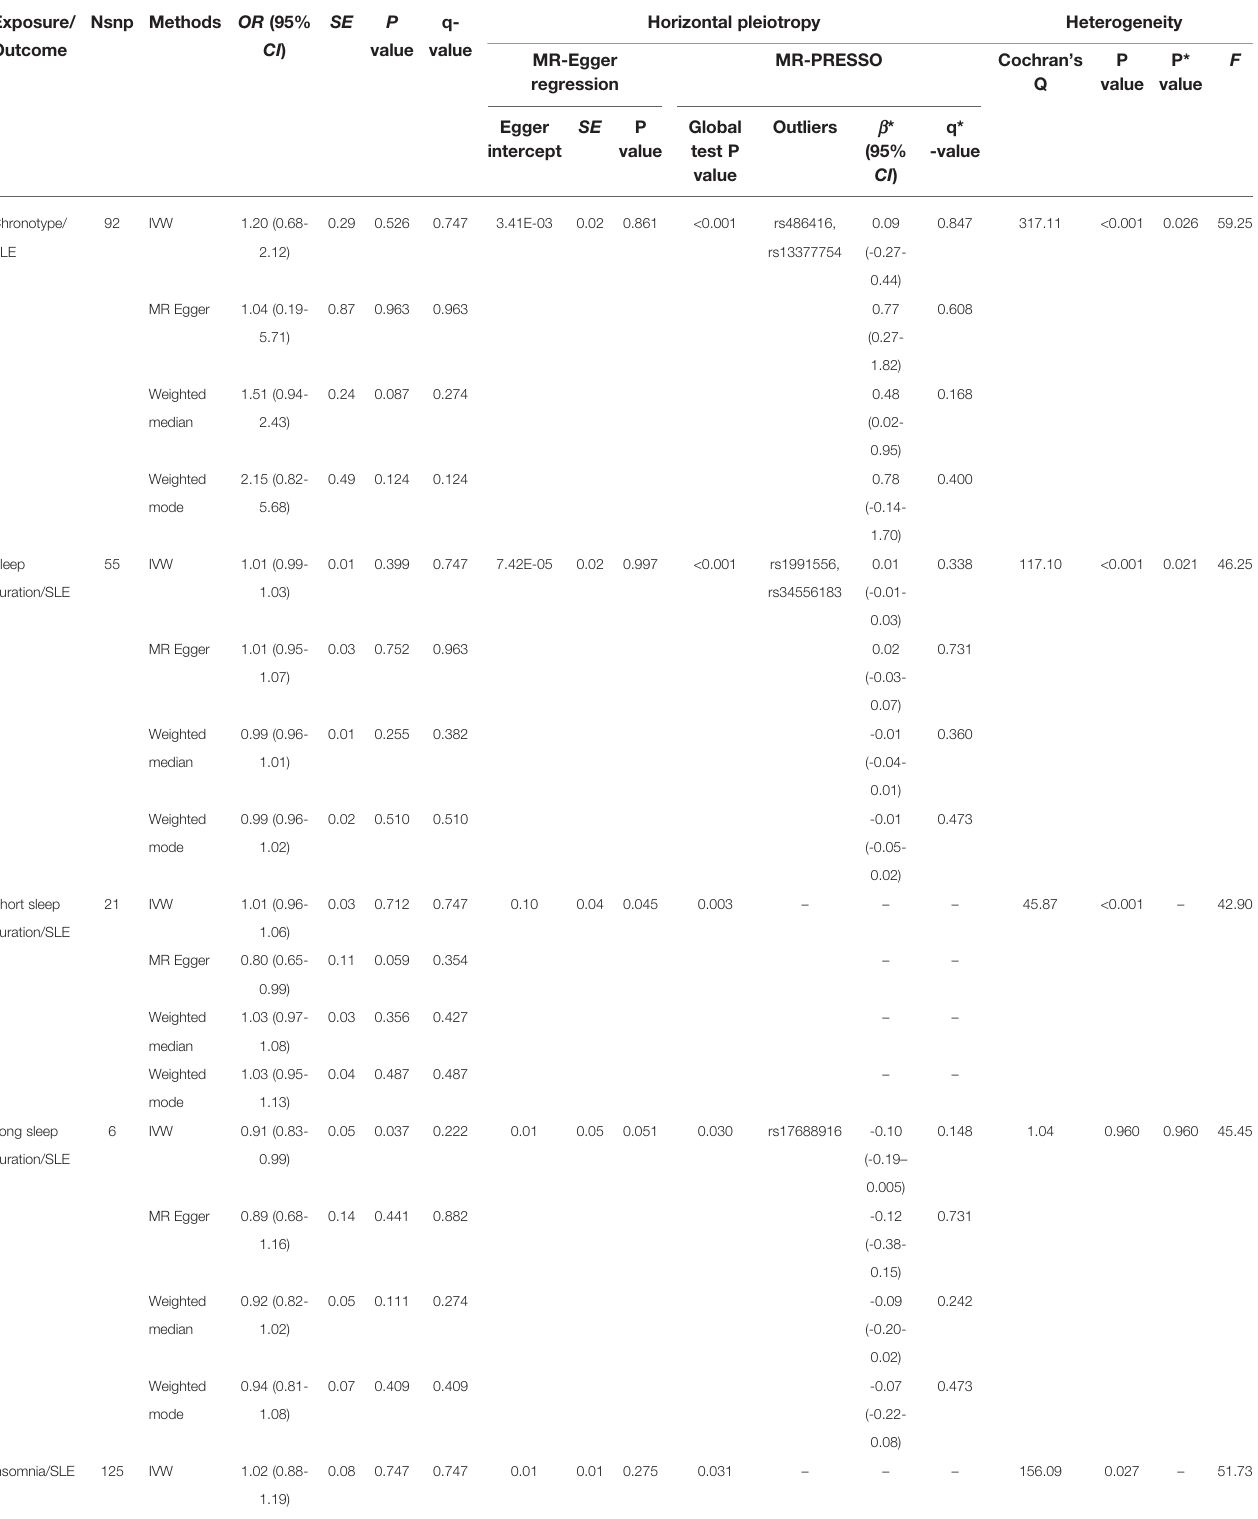
TABLE 1 | MR analysis for the causality of sleep traits with the risk of SLE.